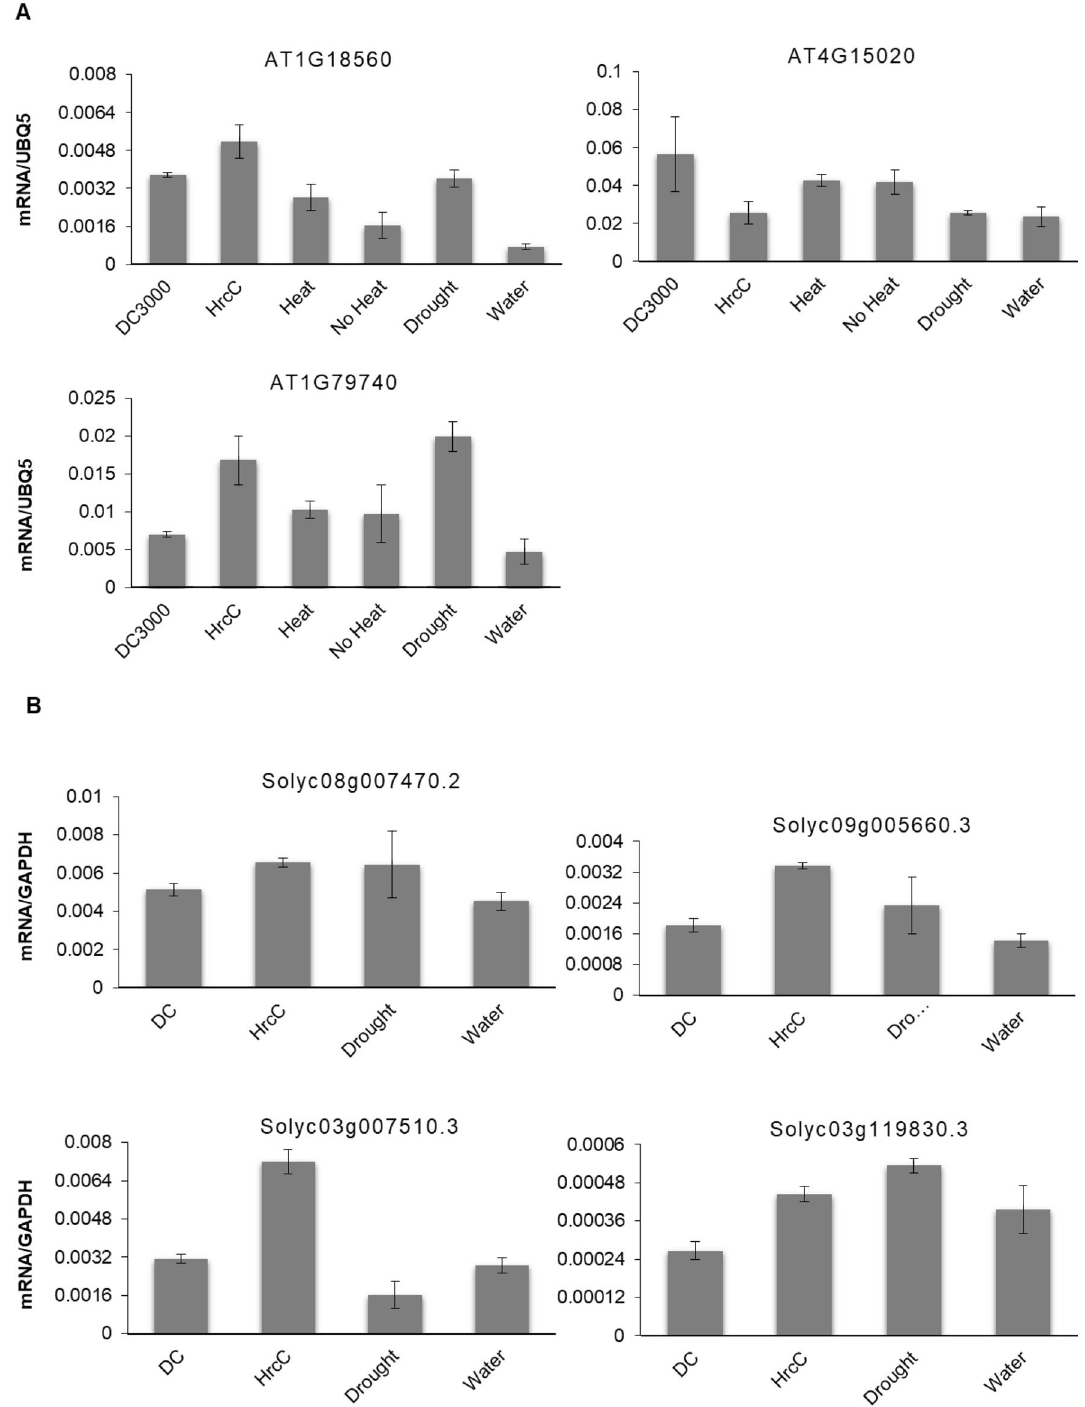
Figure 8. RT-qPCR analysis of Zf-BED mRNAs accumulation in Col-0 and Micro-Tom treated by biotic and abiotic stresses. ( A ) Transcript levels of Zf-BED genes in 4-week-old Col-0 genotype upon treatment with Pseudomonas syringae pv. tomato DC3000 (DC3000) and effector less mutant strain Pto DC3000 HrcC- (HrcC-) at 48 h, 37 °C (Heat) and room temperature (No heat) at 1 h, as well as no irrigation (Drought) and normal irrigation (Water) at 7 days. Gene expression was assessed using reference gene UBQ5 in AT1G18560, AT4G15020 and AT1G79740 . ( B ) Transcript levels of Zf-BED genes in 3-week-old Micro-Tom genotype upon treatment with DC3000 and HrcC- at 48 h, as well as no irrigation (Drought) and normal irrigation (Water) at 7 days. Gene expression was assessed using reference gene GAPDH in Solyc08g007470.2 , Solyc09g005660.3, Solyc03g007510.3 and Solyc03g119830.3